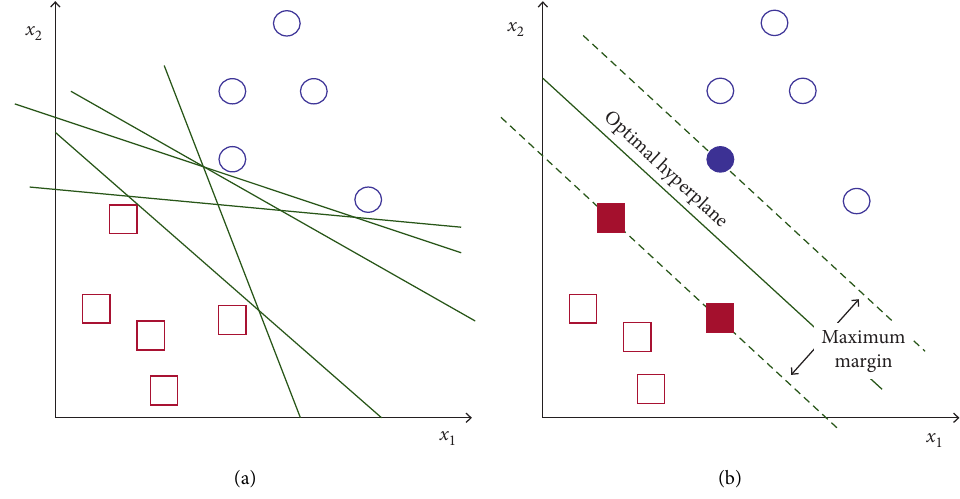
Figure 7: Possible hyperplanes (left) and optimal hyperplane (right).